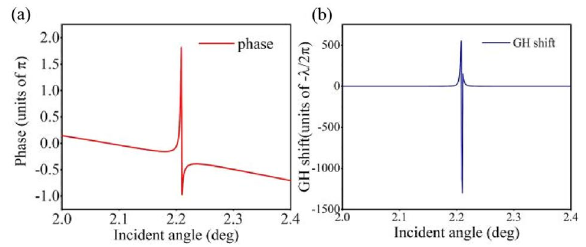
Figure 8. ( a ) TE reflection phase angular spectra with λ = 674.0 nm. ( b ) GH shift angular spectra with the asymmetric geometric parameter set to δ =